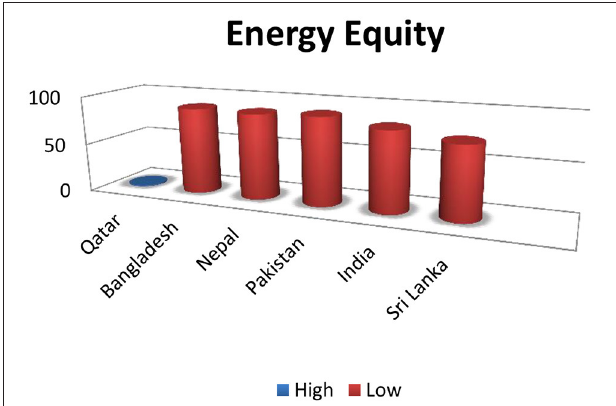
FIGURE 2 | Higher numbers denoting insecurity, compared with Qatar: (16).